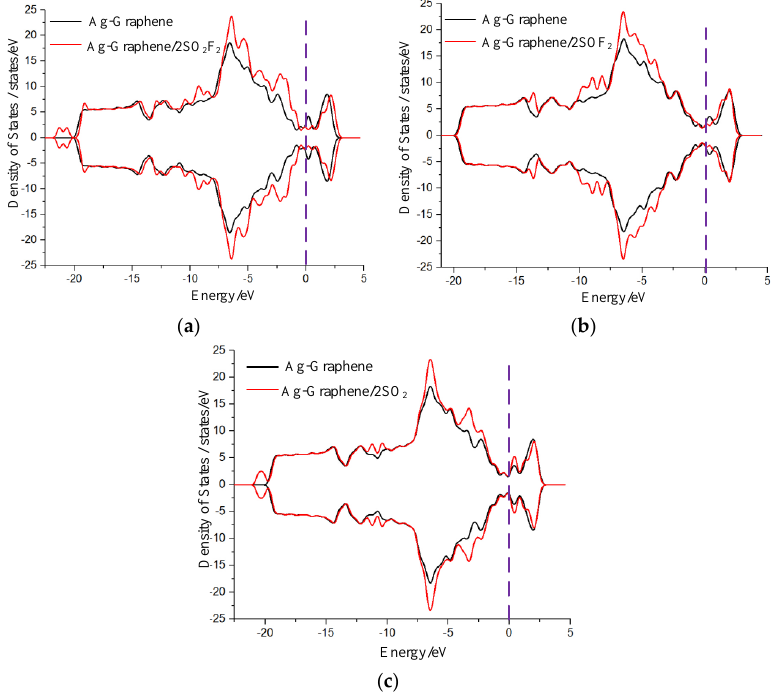
Figure 11. DOS for Ag-graphene with and without double molecule adsorption in ( a ) SO 2 F 2 ; ( b ) SOF 2 ; and ( c ) SO 2 .